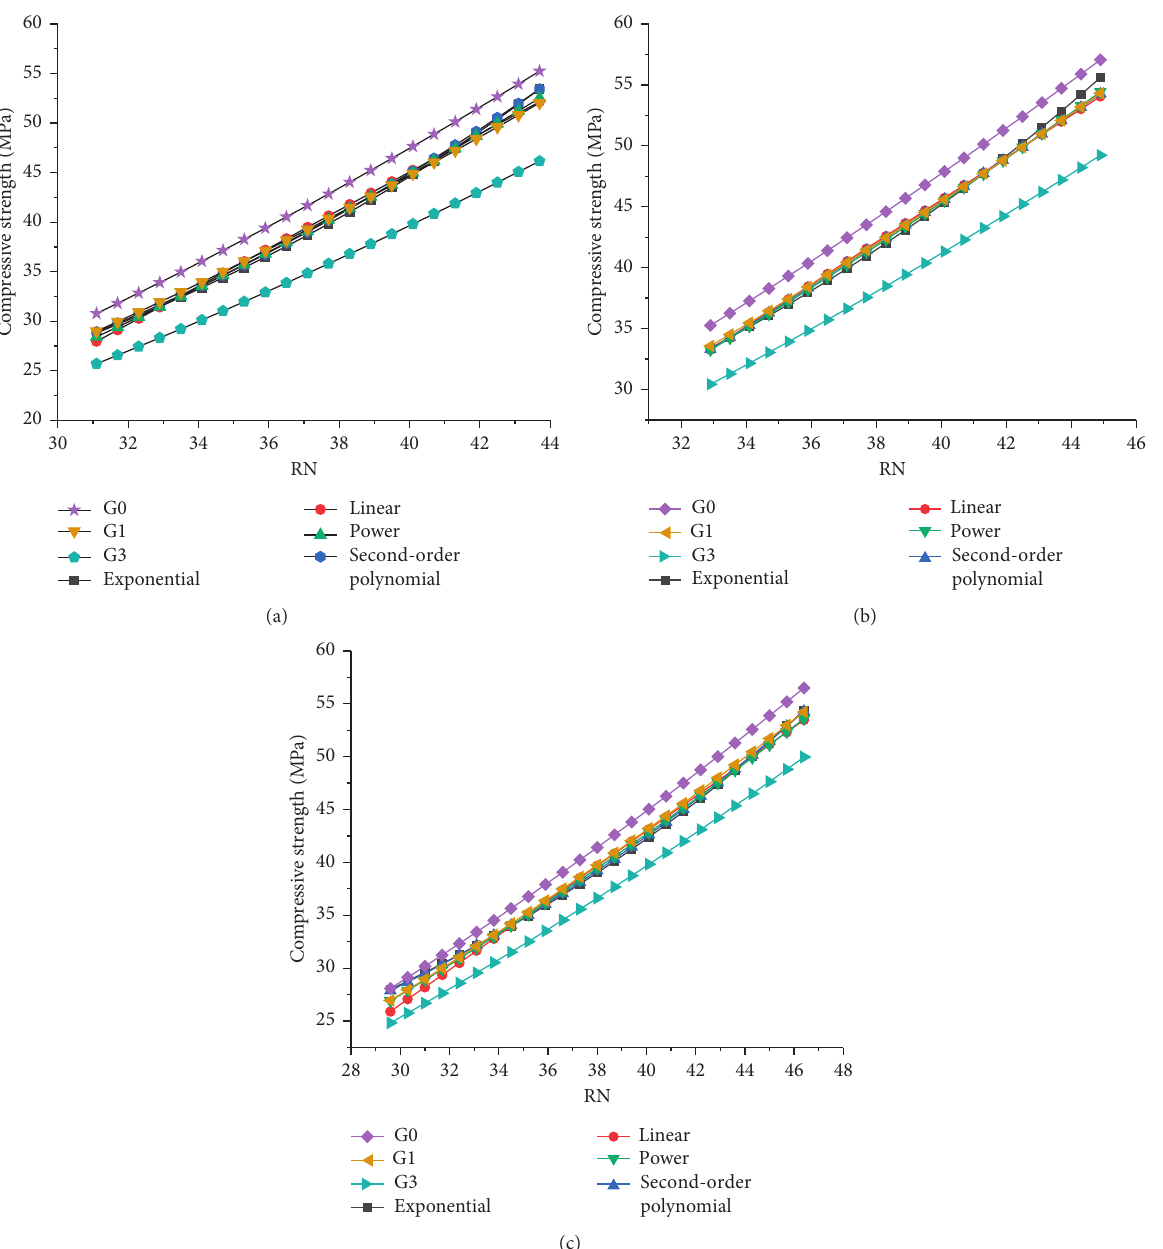
Figure 4: Regression curves of (a) PFRC, (b) CFRC, and (c) HFRC predicted using the G0, G1, G3, exponential, linear, second-order polynomial, and power models. Table 6: Model equations used to estimate the relationship between PFRC compressive strength and RN. Regression models